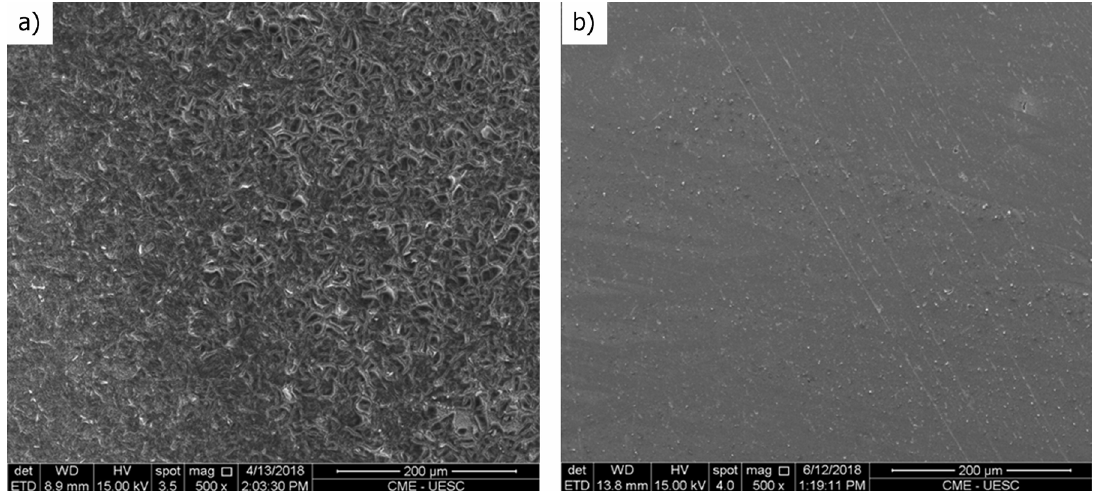
Figure 11. SEM micrographs of SAE 1008 carbon steel surface after immersion in the electrolyte, in the absence (a) and in the presence of inhibitor (b).